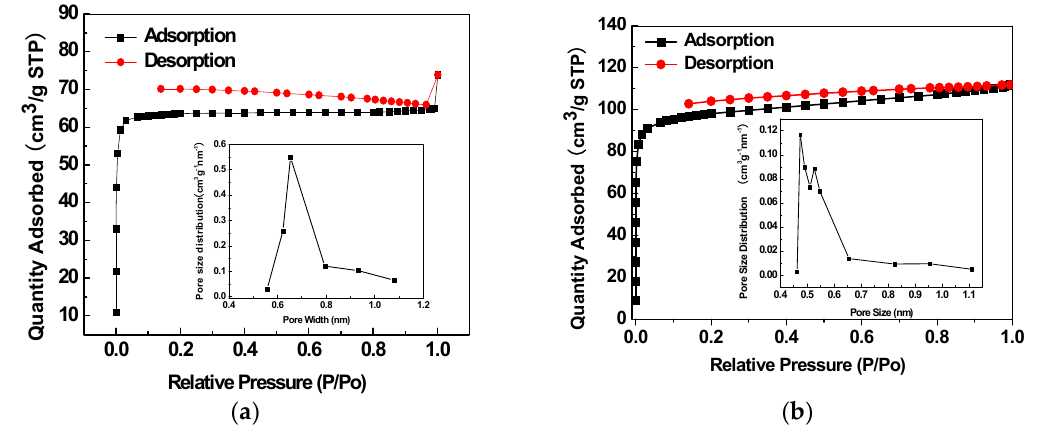
Figure 20. Nitrogen adsorption isotherms and pore size distributions of ( a ) SBA-15 and ( b ) MCM-48.